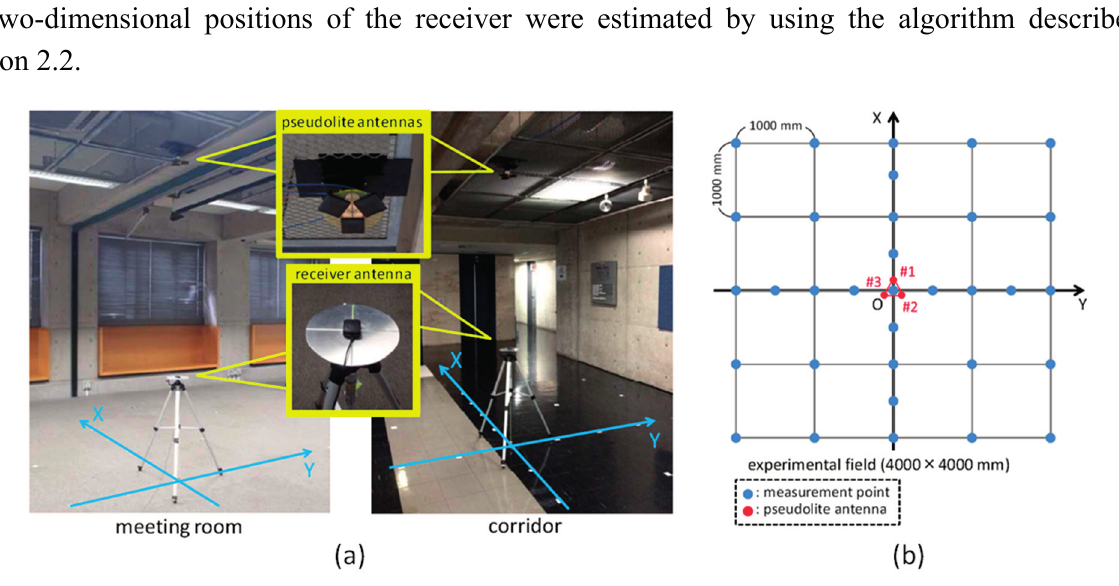
Figure 4. ( a ) Appearance of experimental fields; ( b ) Measurement points of CPD and positions of pseudolite antennas on horizontal